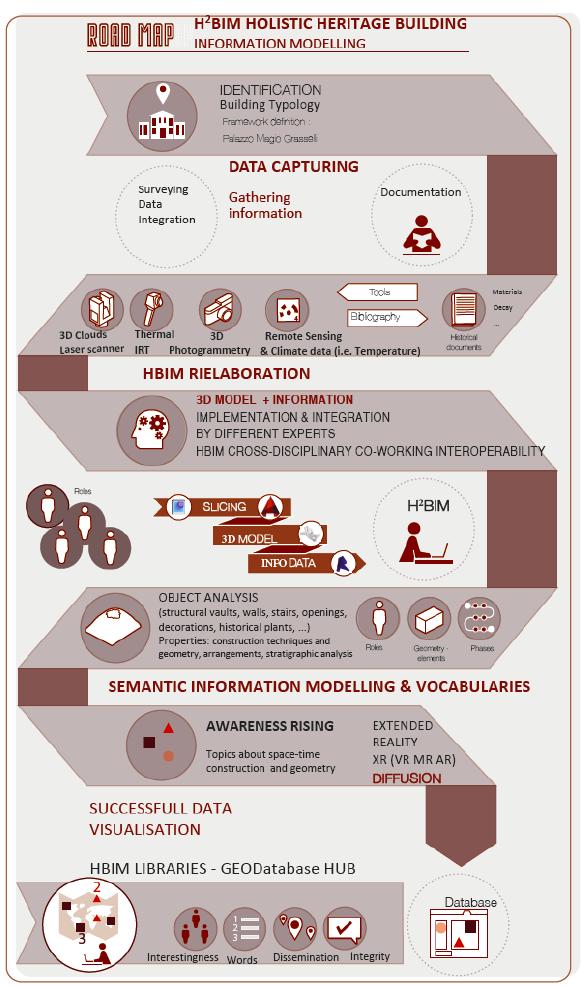
Figure 10. Holistic HBIM HUB workflow